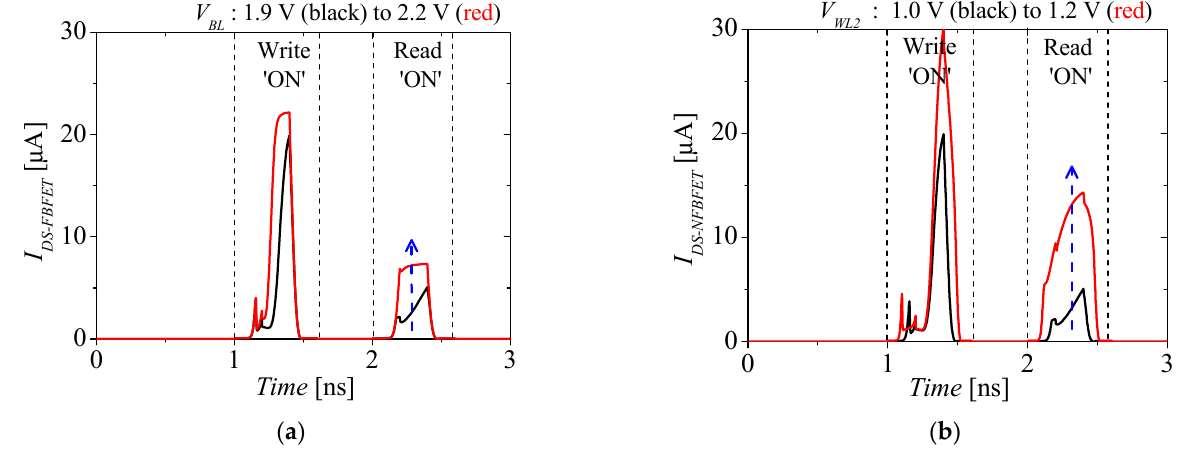
Figure 8. The reading ‘ON’ current of the M3D − FBFET − SRAM cell with T ILD = 3 nm. ( a ) V BL = 1.9 (black lines), and 2.2 V (red lines), and ( b ) V WL2 = 1.0 (black lines) to 1.2 V (red lines).